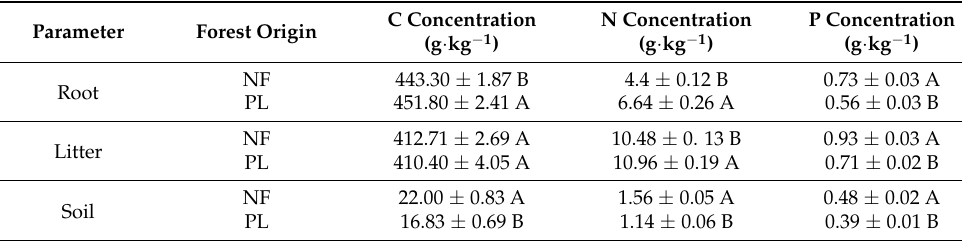
Table 1. Concentrations of C, N, and P in roots, litter and soil in NF and PL in forest ecosystems in China.